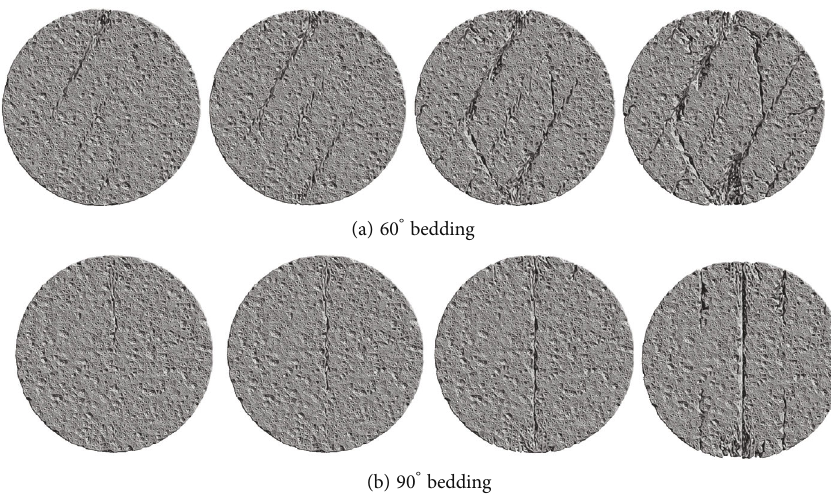
Figure 15: Diagram of the failure process of solid bond elements under the 60 ° and 90 ° bedding